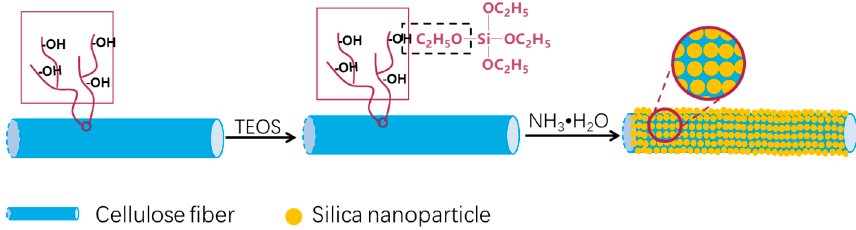
Figure 1. Schematic procedure of cellulose fiber-based superhydrophobic paper.